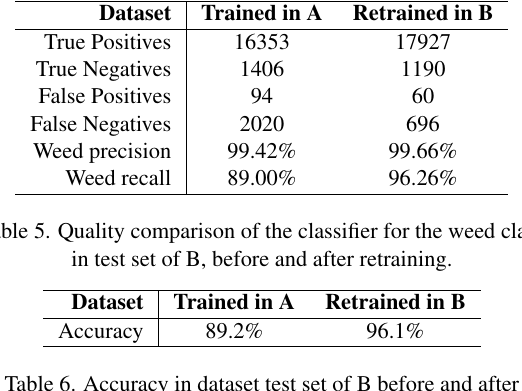
Table 6. Accuracy in dataset test set of B before and after retraining on small subset (15%) of training set of